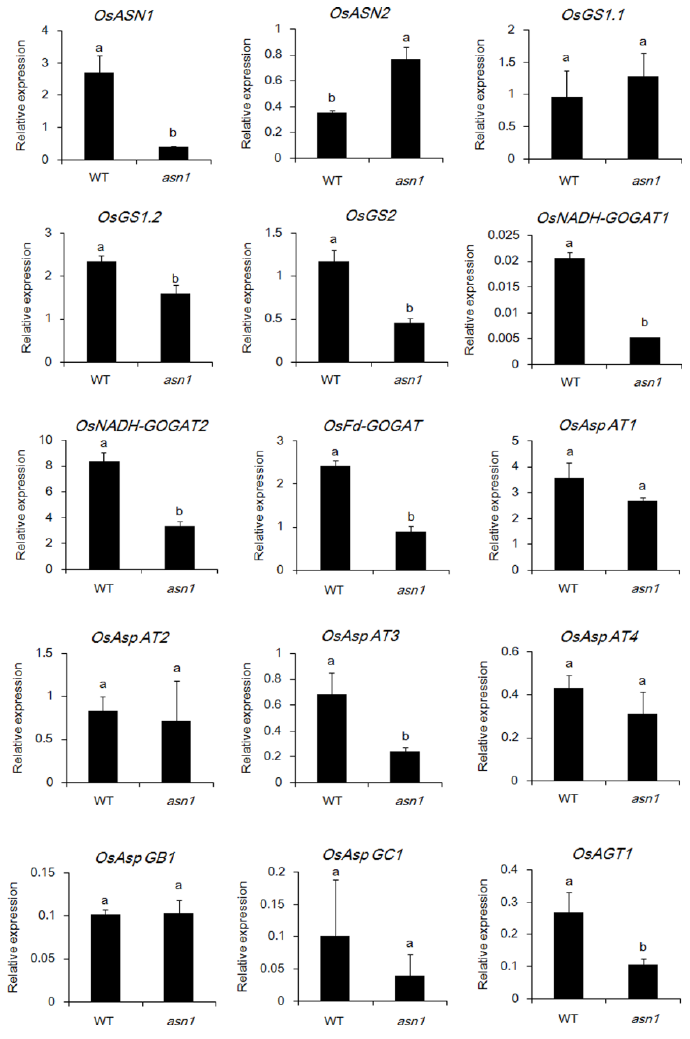
Figure 8. Relative expression of genes involved in the asparagine metabolic pathway. Genes involved in the asparagine metabolic pathway were listed as follows: OsASN1 ( Os03g0291500 ); OsASN2 ( Os06g0265000 ); OsGS1.1 ( Os02g0735200 ); OsGS1.2 ( Os03g0223400 ); OsGS2 ( Os02g0701300 ); OsNADH-GOGAT1 ( Os01g0681900 ); OsNADH-GOGAT2 ( Os05g0555600 ); OsFd-GOGAT ( Os07g0658400 ); OsAspAT1 ( Os01g0760600 ); OsAspAT2 ( Os02g0797500 ); OsAspAT3 ( Os02g0236000 ); OsAspAT4 ( Os06g0548000 ); OsAspGB1 ( Os04g0682500 ); OsAspGC1 ( Os04g0549300 ); and OsAGT1 ( Os08g0502700 ). Plants were grown with normal nitrogen supply for one month and the root-shoot junctions were sampled. The values are the transcriptional expression level of upper listed genes to OsActin (internal standard control) by quantitative PCR. Data are mean ± SD ( n = 3). Means with different letters are significantly different.